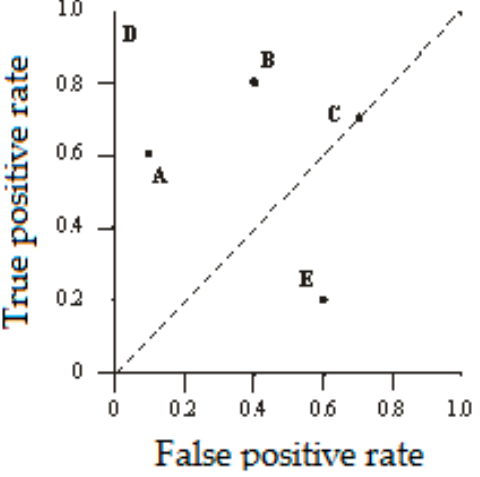
Figure 1. The Receiver Operating Characteristic (ROC) graph of five discrete classifiers.